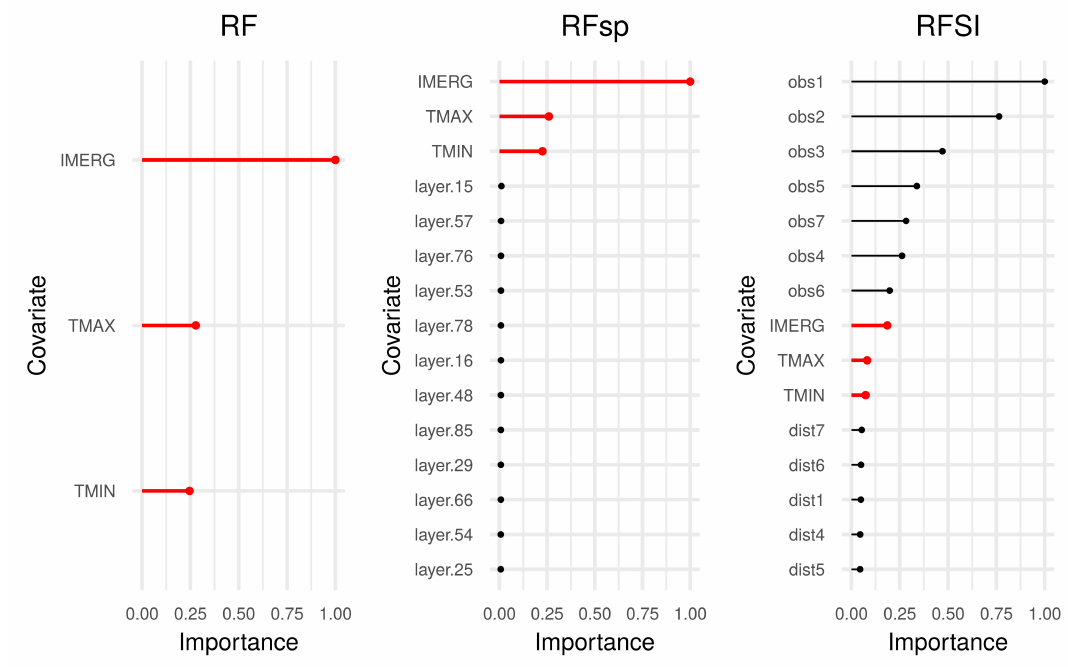
Figure 10. Covariate importance plot for RF ( left ), RFsp ( middle ) and RFSI ( right ), for the precipitation case study. The importance index is scaled to a maximum of 1. The importance of covariates IMERG, TMAX, and TMIN is shown in red.